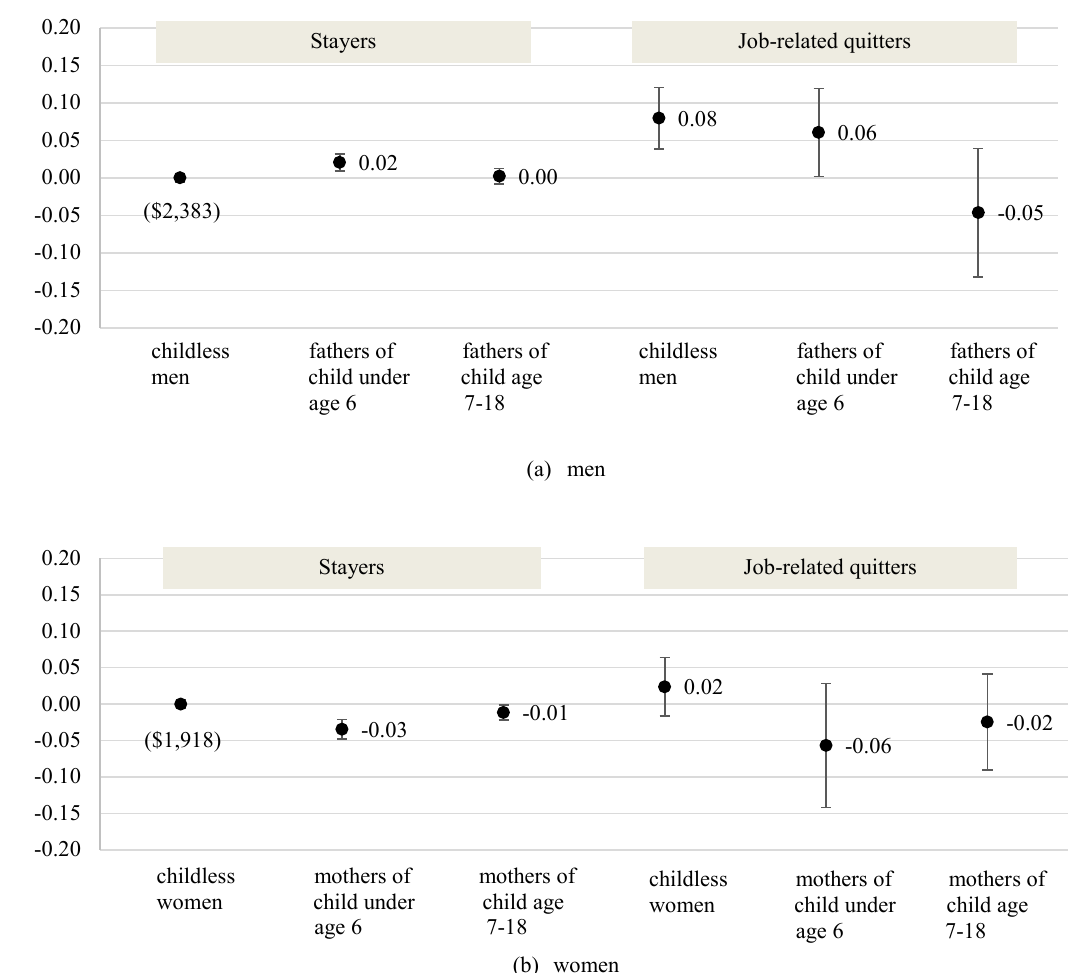
Figure 3: Differences in logged monthly earnings between childless stayers and other workers in the recession